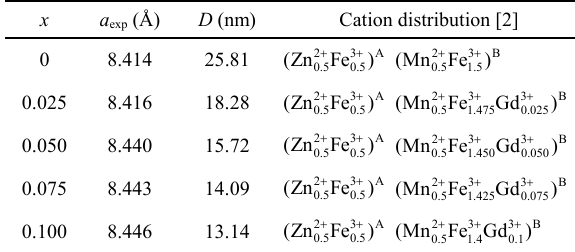
Cation distribution, variation of